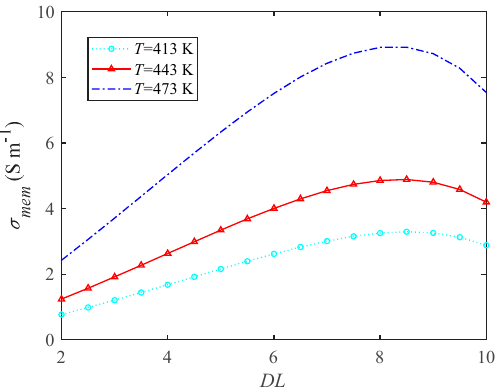
Figure 6. The influence of doping level on proton conductivity.